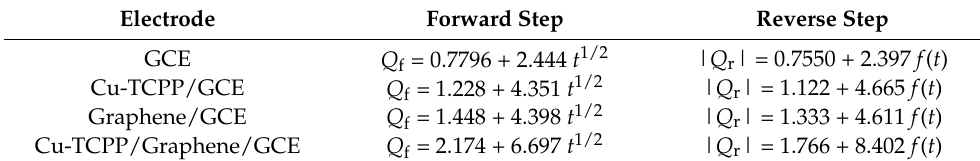
Table 1. The linear regression equations of Q f - t 1/2 and Q r - f ( t ) on different GCEs.